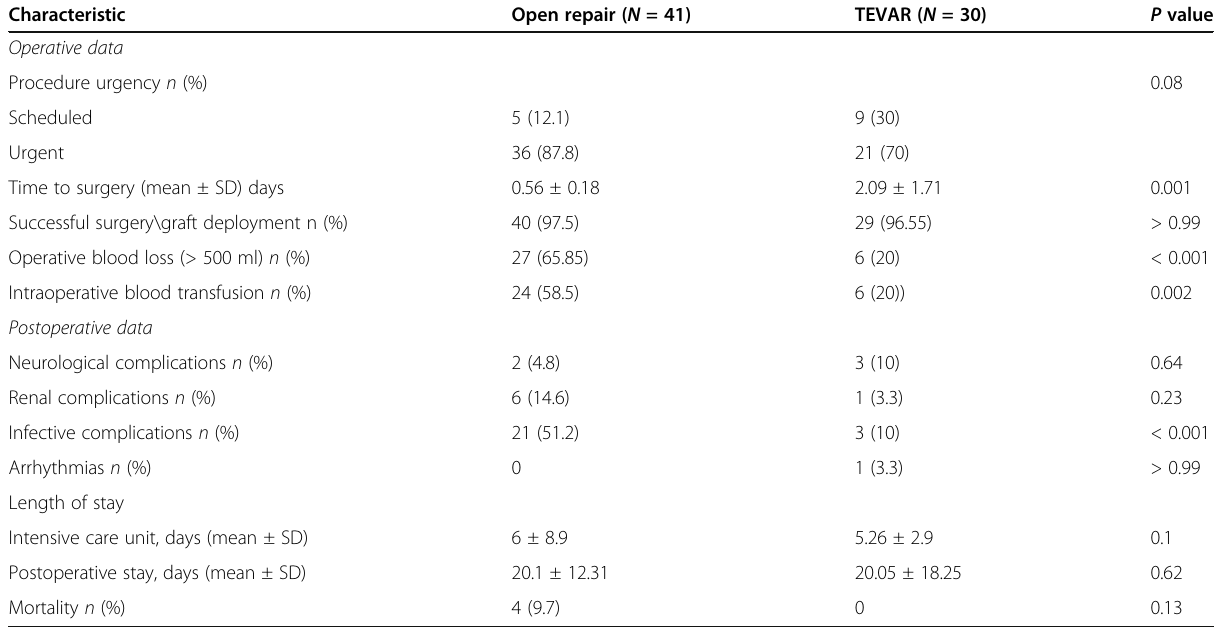
Table 2 Operative and postoperative data